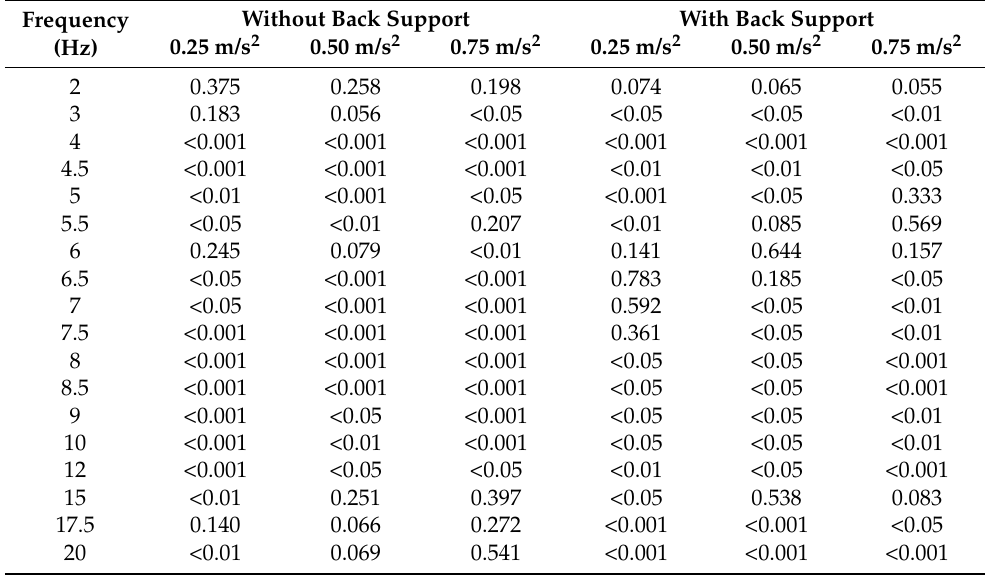
Table 3. p -values obtained from one-way r ANOVA of vertical STHT magnitudes between the elastic seats for two back support conditions and three levels of excitation.